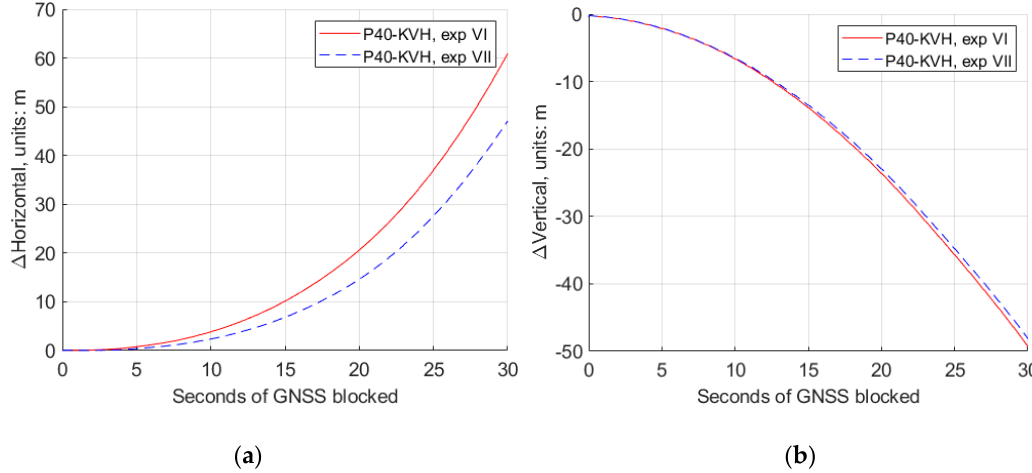
Figure 11. The horizontal and vertical position differences between GNSS/IMU-P40 (our program in a 15-state Kalman filter) and GNSS/KVH coupled navigation (IE software), with the conventional Kalman filter (experiment VI) and the modified Kalman filter (experiment VII). ( a ) Horizontal position differences; ( b ) vertical position differences.